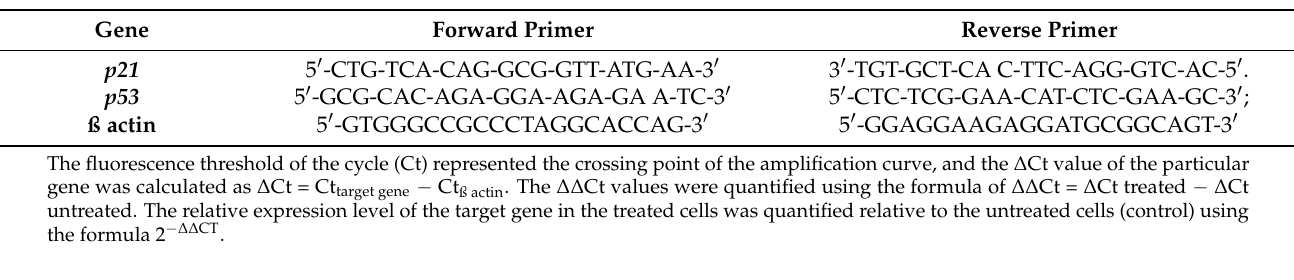
Table 9. Oligonucleotide primers used for real-time RT-PCR